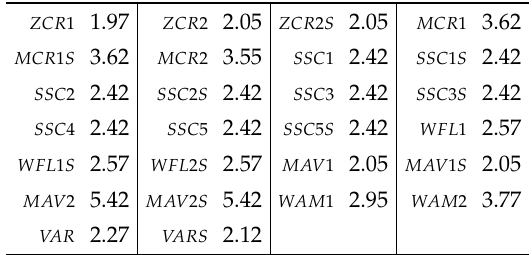
Table 9. Runtime of input features in µ s at a 48MHz clock.